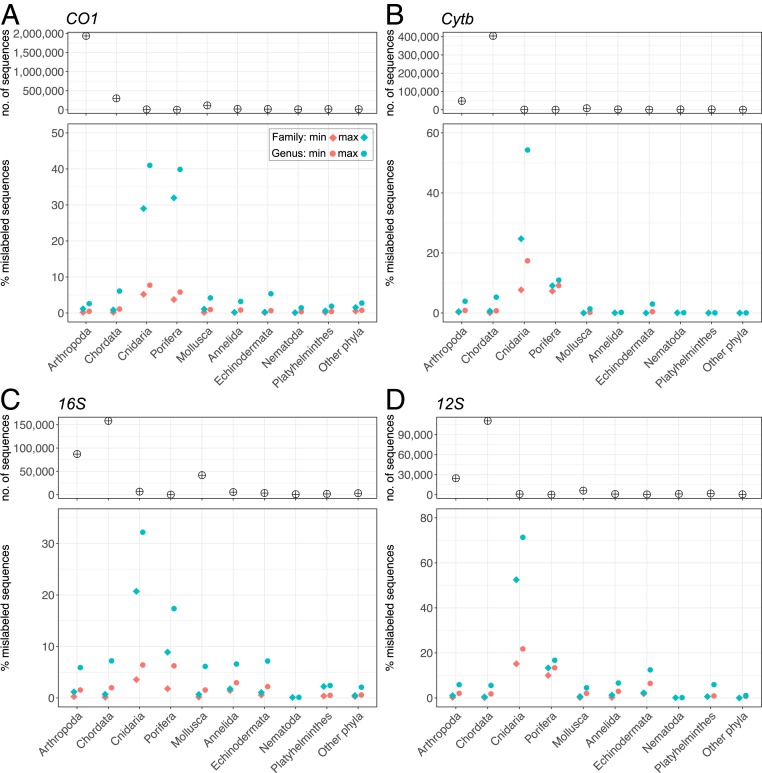
Number of sequences and estimated percentage of mislabeled sequences at the genus and family levels across major metazoan phyla: (A) CO1; (B) Cytb; (C) 16S; and (D) 12S. The category “Other phyla” includes sequences of Acanthocephala, Brachiopoda, Bryozoa, Chaetognatha, Ctenophora, Cycliophora, Entoprocta, Gastrotricha, Hemichordata, Kinorhyncha, Nematomorpha, Nemertea, Onychophora, Placozoa, Priapulida, Rhombozoa, Rotifera, Tardigrada, and Xenacoelomorpha.